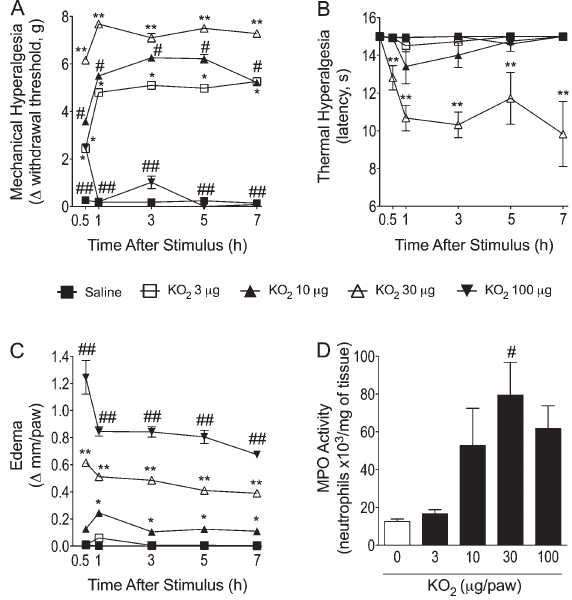
Figure 1. Intraplantar ( ipl ) injection of KO 2 induced hyperalgesia, edema, and neutrophil recruitment. Mice received KO 2 (3-100 m g, 25 m L, ipl ) or saline injection. The intensity of mechanical hyperalgesia ( A ), thermal hyperalgesia ( B ), and the paw edema ( C ) were measured 0.5-7 h after stimulus, and myeloperoxidase (MPO) activity at 7 h. Data are reported as means±SE. *P , 0.05 vs saline control; # P , 0.05 vs 3 m g; **P , 0.05 vs 10 m g; ## P , 0.05 vs 30 m g (one-way ANOVA followed by Tukey’s t